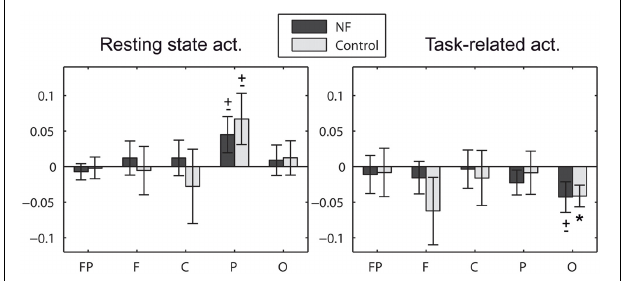
FIGURE 6 | Initial alpha asymmetry scores measured in prefrontal (FP: FP2 − FP1), frontal (F: F4 − F3), central (C: C4 − C3), parietal (P: (P7 + P3)/2 − (P8 + P4)/2), and occipital (O: O2 − O1) areas of the scalp. Positive asymmetry scores denote left over right activation, i.e., more alpha power in right hemisphere locations. ∗ significant effect ( p < 0 . 05), ± statistical trend ( p < 0 . 1). Note that statistical results are not corrected for the multiple